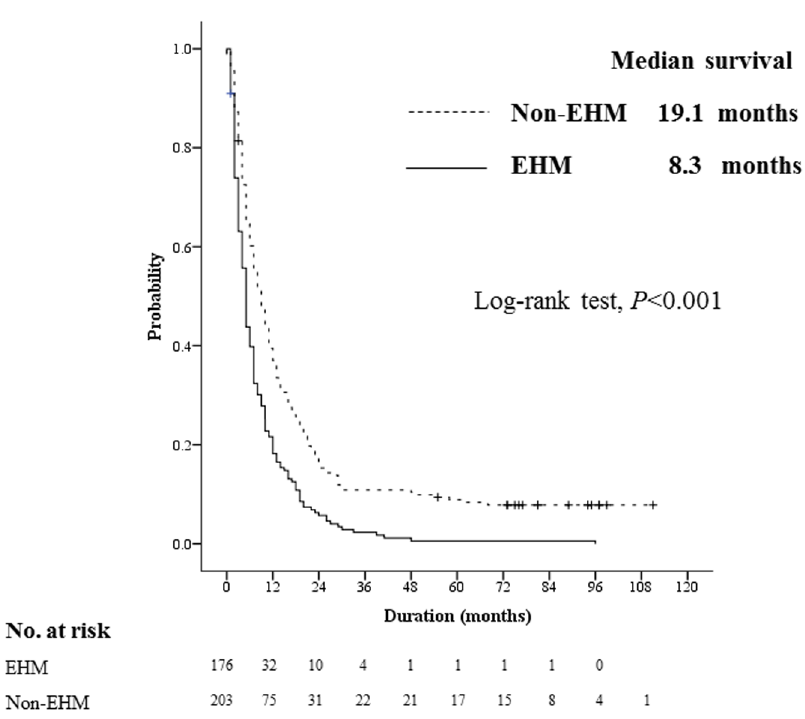
Figure 1. Kaplan-Meier survival curve for the EHM and the non-EHM group. Within the same BCLC stage C, the OS of the EHM group (solid line) was worse than the non-EHM group (dotted line) (median, 8.3 months vs. 19.1 months; P ,